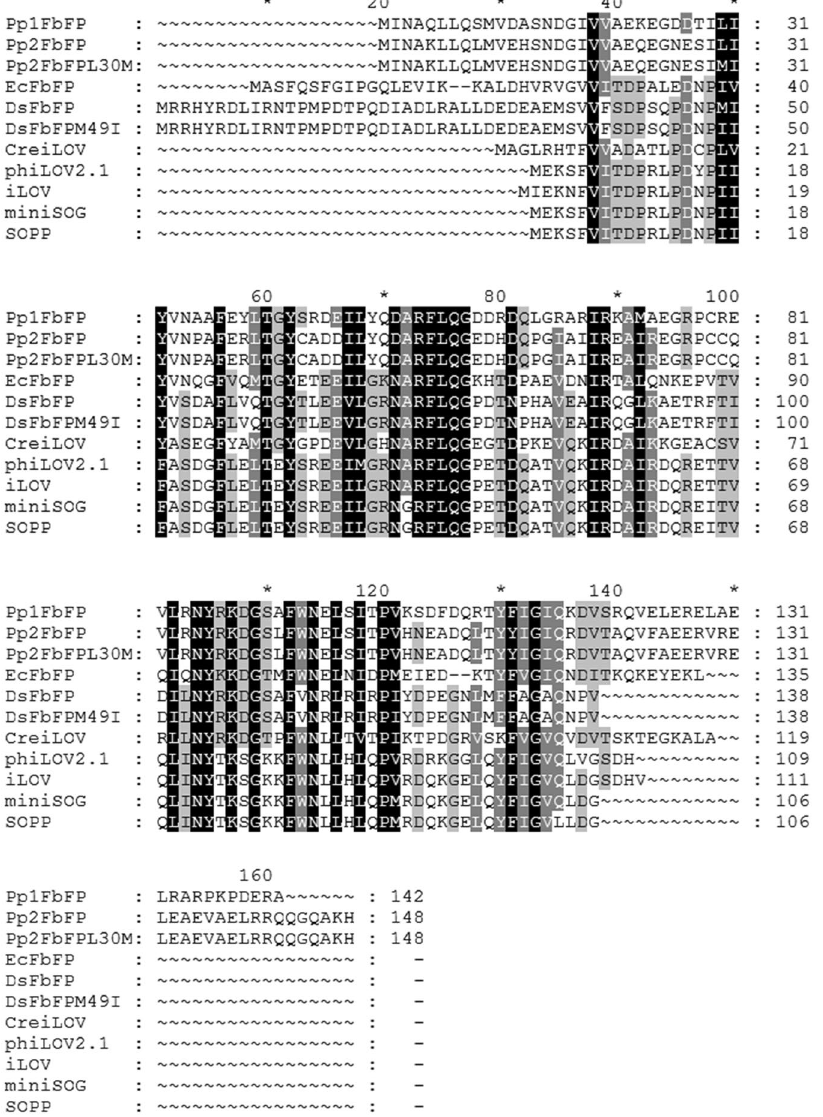
Figure 1. Multiple amino acid sequence alignment of the tested LOV-based fluorescent proteins. Homologous and similar residues are marked in black and